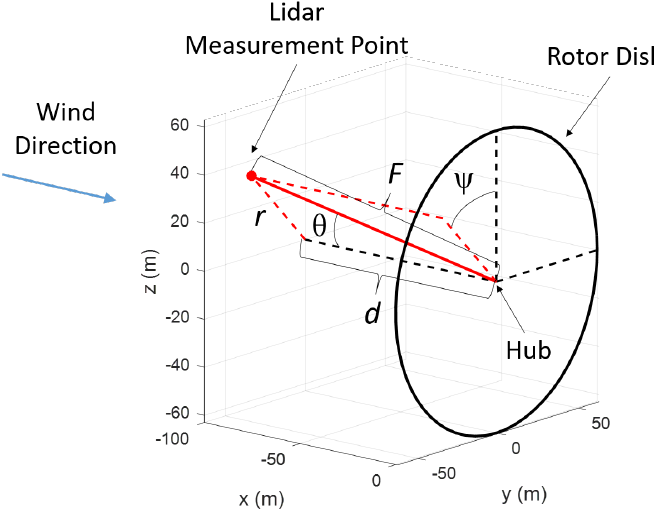
Figure 1. Scan pattern coordinate system and scan variables for a single lidar measurement point.